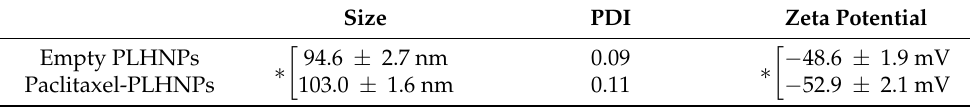
Figure 1. The effect of organic solvents on ( a ) size, PDI, and ( b ) zeta potential of PLGA–lipid hybrid nanoparticles (PLHNPs). Data are reported as mean ± SD from three independent experiments, * p < 0.05 compared between the two organic solvents. Table 1. Characteristics of paclitaxel-PLHNPs. Data are reported as mean ± SD from three indepen-